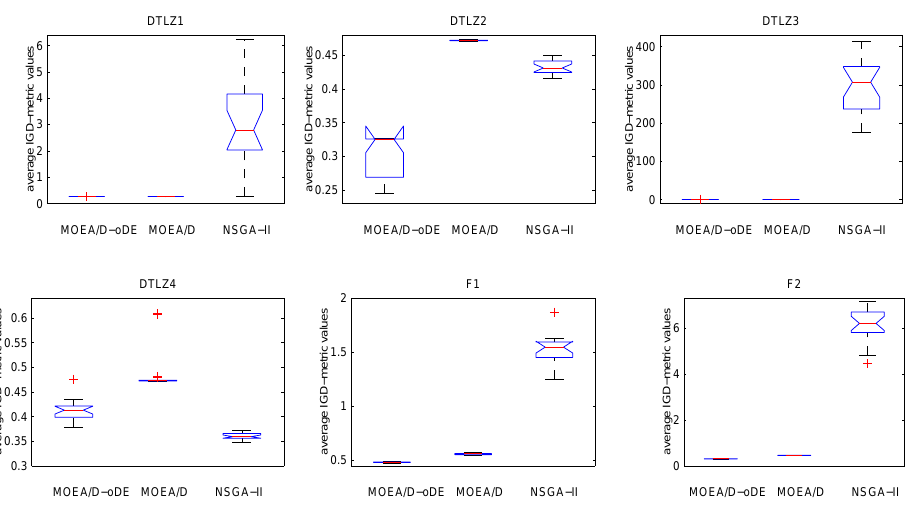
Figure 8. Box plots of the IGD metric values based on 20 independent runs for six-objective test